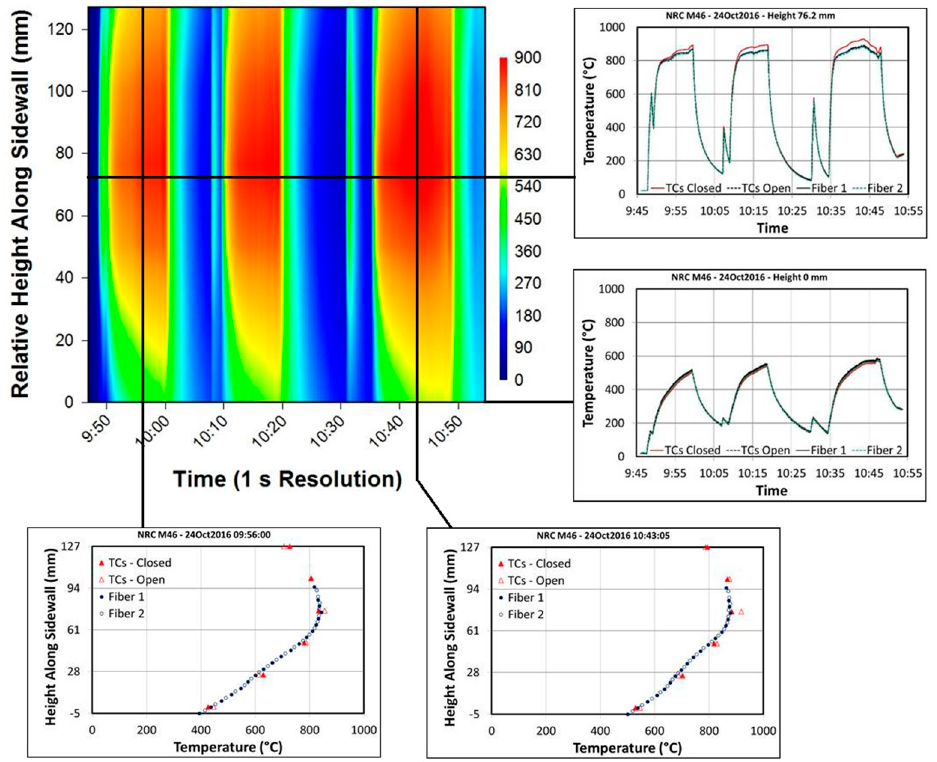
Figure 12. Comparison examples of sidewall temperature measurements at various points in time and space.